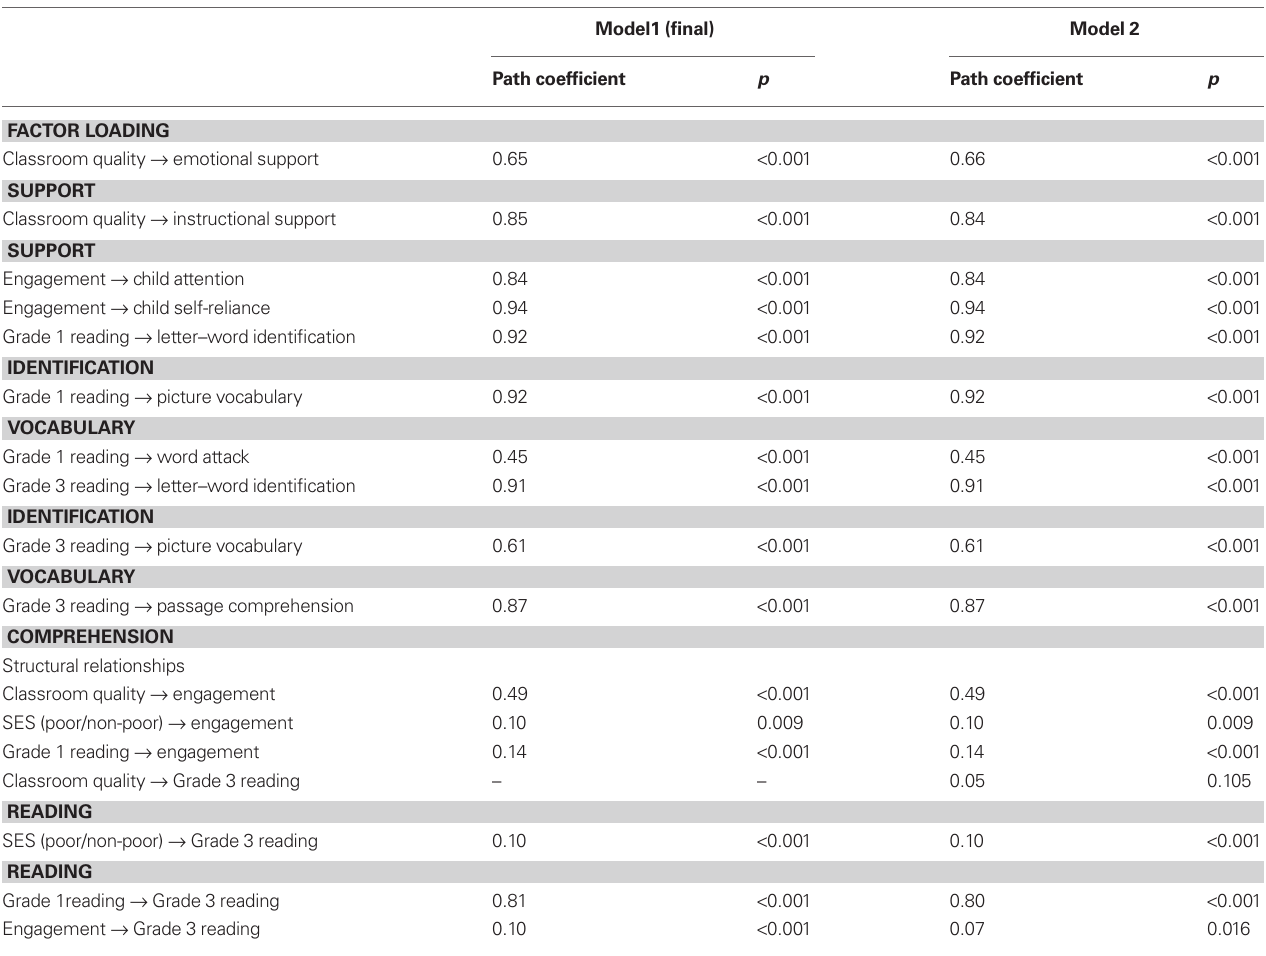
Table 3 | Standardized parameters for the final